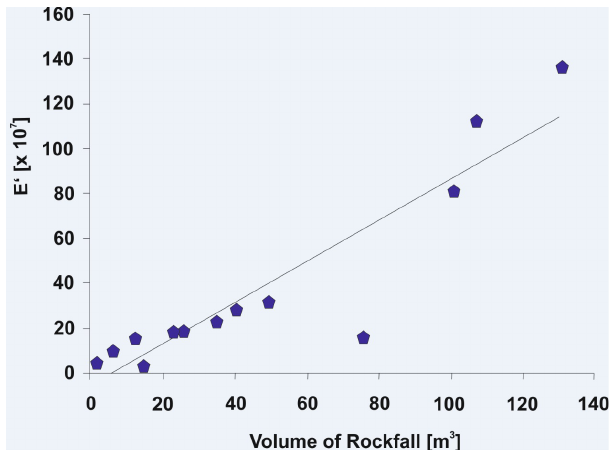
Fig. 9. Rockfall volume vs. seismic signal related energy with aver- aged trend line. A good correlation was obtained between estimated volume and seismic signal energy value E 0 which is a pseudo – en- ergy and stands for a number that is approximately proportional to the actual seismic energy without units. R 2 between E 0 and rockfall volume is 0.92.